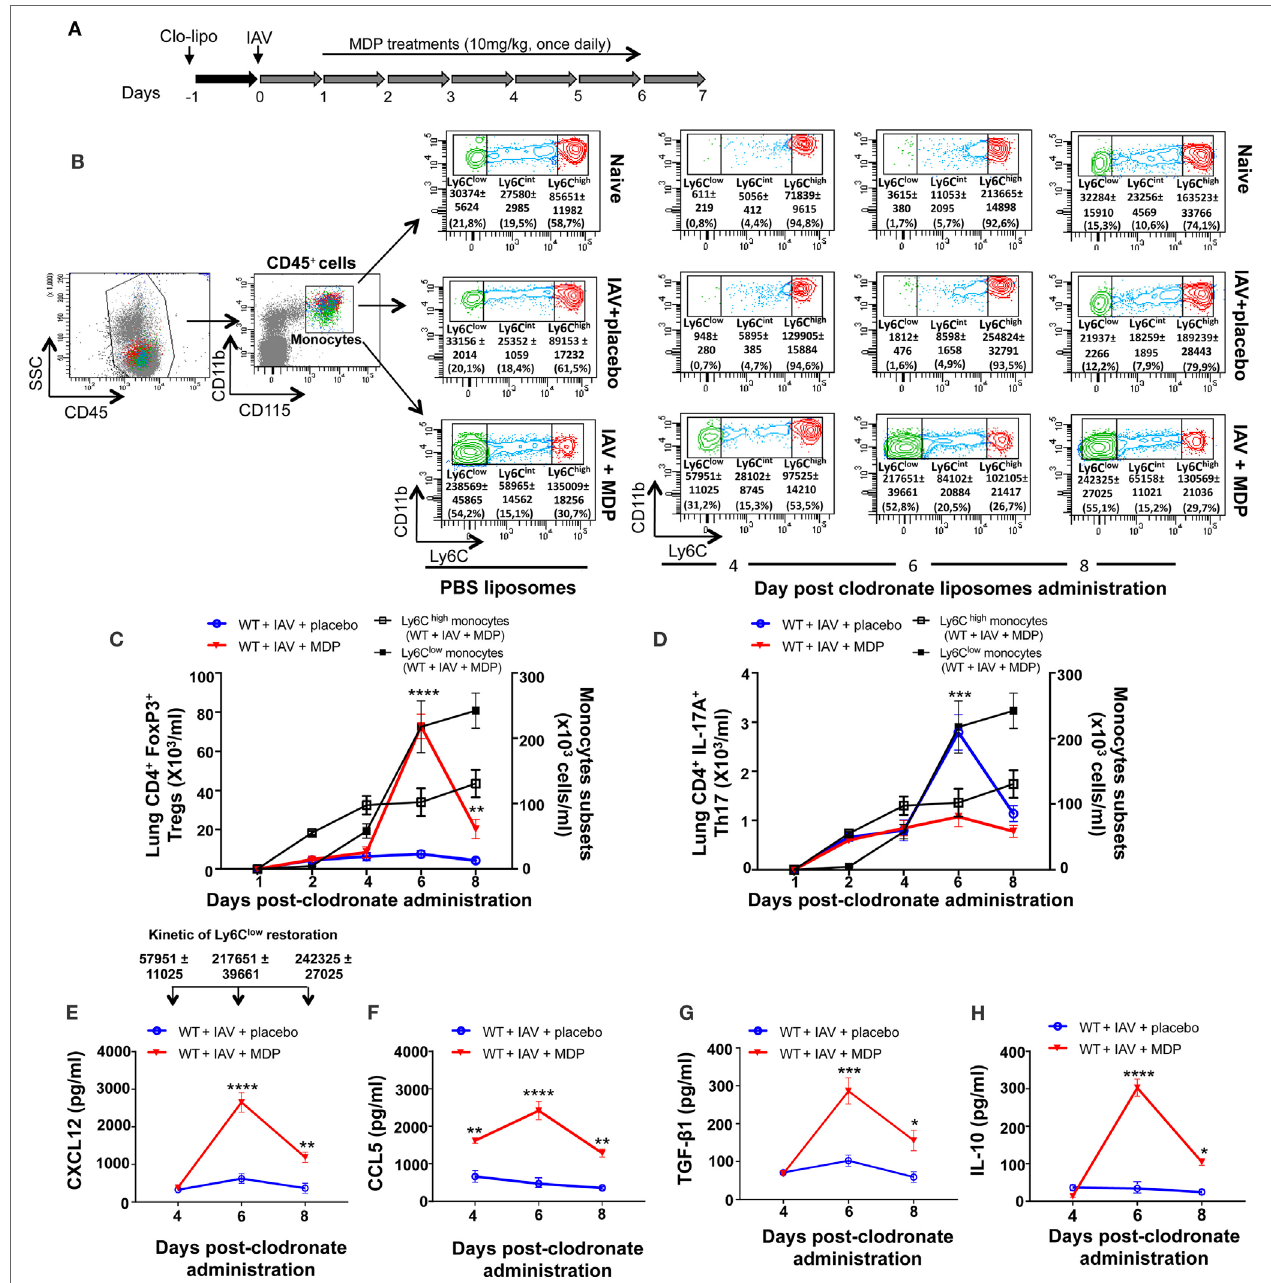
FigUre 5 | Ly6C low monocytes are involved in regulatory T (Treg) cells mobilization to lungs of influenza A virus (IAV)-infected mice. (a) Experimental design of blood monocyte depletion. Briefly, 1 day prior to IAV infection, mice were treated with clodronoate-liposome (200 µl i.v.) to deplete blood monocytes. (B) Gating strategy of blood monocytes subsets. After gating out the neutrophil cell population (CD45 + /CD11b + /Ly6G + ), monocytes were identified as CD45 + , CD11b + , and CD115 + . Monocyte subsets were further subdivided in three populations based on their expression level of Ly6C: Ly6C high , Ly6C int , and Ly6C low . Flow cytometry analysis of blood monocytes subsets was assessed at day 6 following PBS liposome administration and at days 4, 6, and 8 postclodronate liposome injection. (c) Treg and (D) Th17 cells numbers in lung tissues were measured by flow cytometry at days 1, 2, 4, 6, and 8 postclodronate administration in IAV-infected mice daily treated with placebo or muramyl dipeptide (MDP). Number of Ly6C high and Ly6C low monocytes (black curves) in the blood of IAV-infected mice treated with MDP is shown to illustrate monocytes subsets replenishment following clodronate liposome administration. Results are presented as mean ± SEM of two independent experiments ( n = 4 mice/groups). Differences in groups were determined with a two-way analysis of variance followed by a Sidak post hoc test. ** p < 0.01, *** p < 0.001, and **** p < 0.0001, IAV-infected mice treated with placebo (blue) compared to IAV-infected MDP-treated animals (red). Levels of CXCL12 (e) , CCL5 (F) , TGF- β 1 (g) , and IL-10 (h) in lung homogenates were determined at days 4, 6, and 8 postclodronate administration in mice infected with IAV and daily treated with placebo or MDP. Arrows [in panel (e) ] show the number of restored Ly6C low monocytes in the blood of WT IAV-infected mice treated with MDP at days 4, 6, and 8 postclodronate liposome administration. This kinetic of Ly6C low monocytes restoration is applicable to figure (e–h) . Results are presented as mean ± SEM of two independent experiments ( n = 4 mice/groups). * p < 0.05, ** p < 0.01, *** p < 0.001, and **** p < 0.0001, when compared with IAV-infected mice treated with